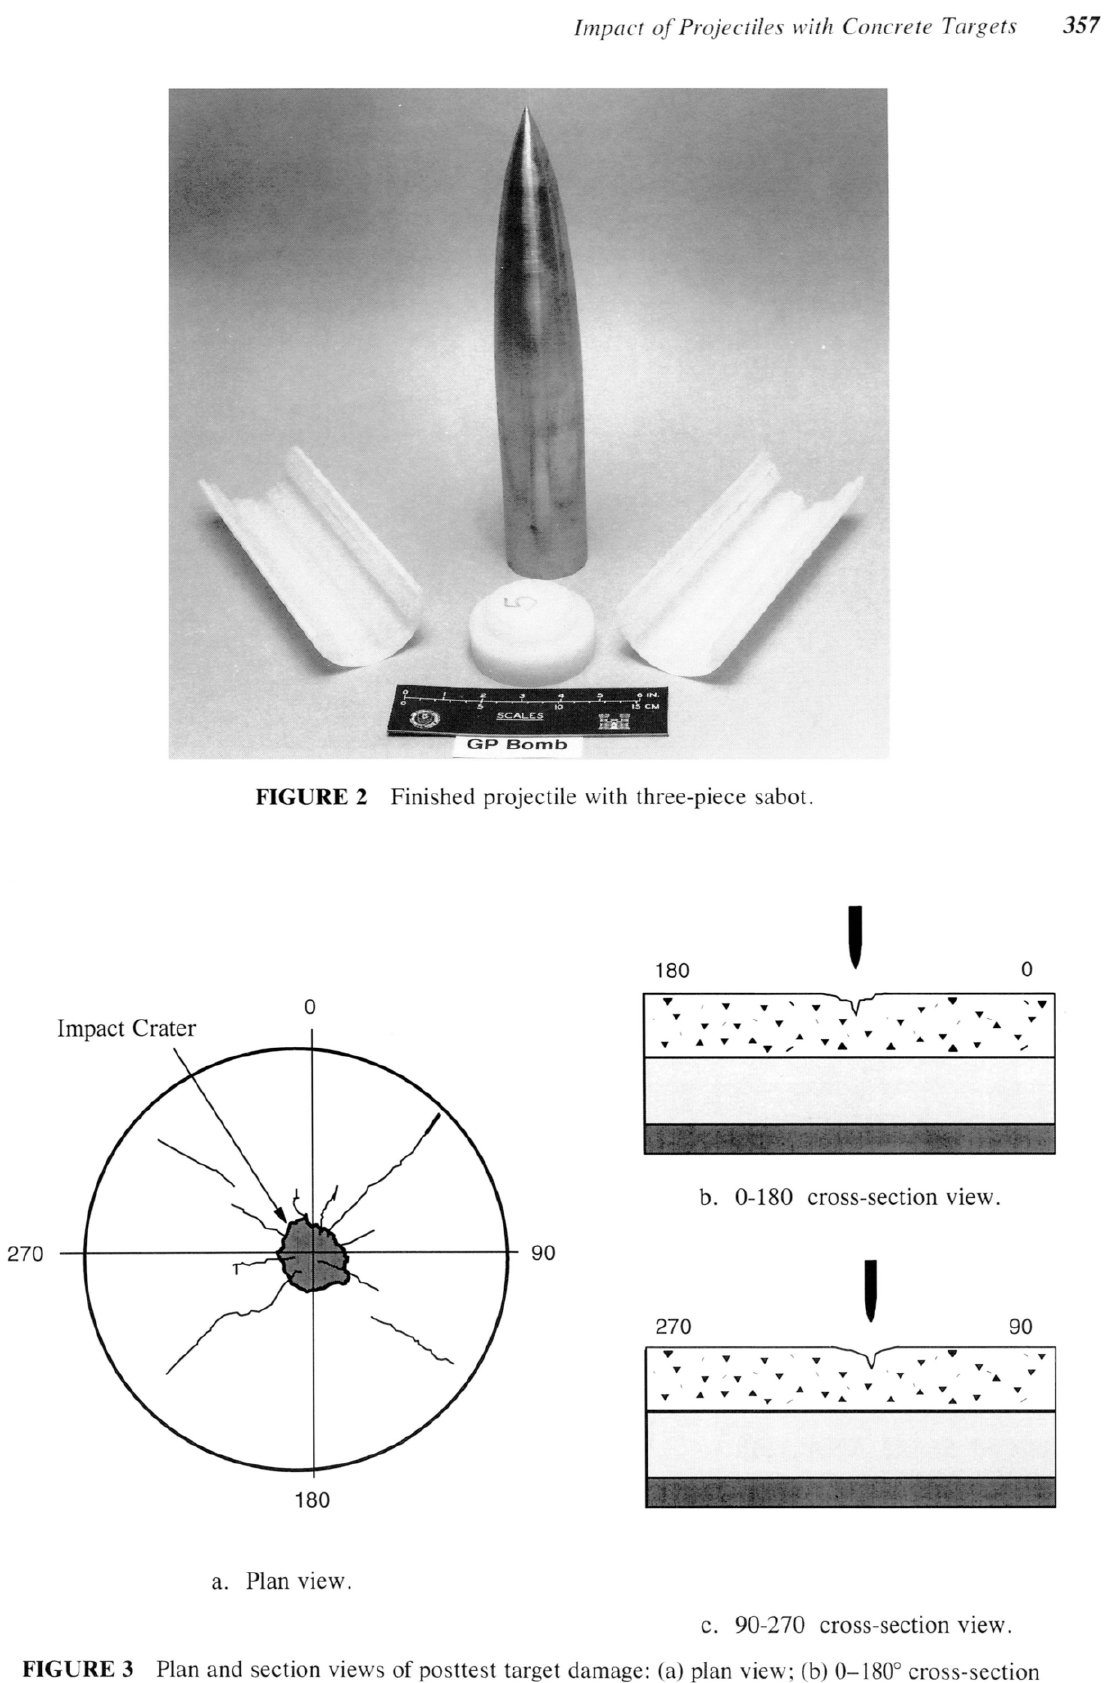
FIGURE 3 Plan and section views of posttest target damage: (a) plan view; (b) 0-180° cross-section view; (c) 90-270° cross-section